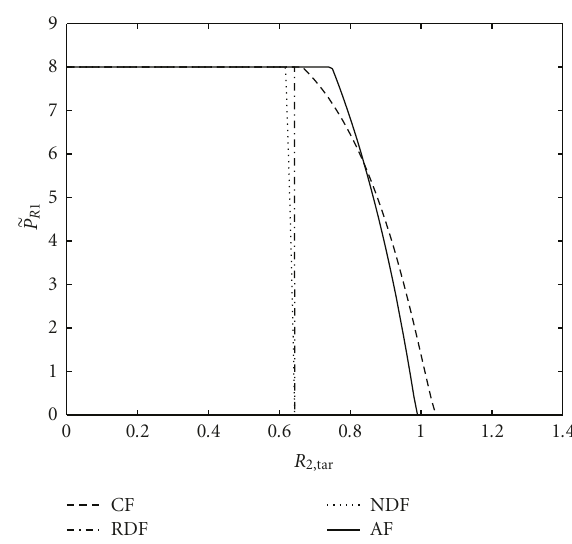
Figure 4: Powers allocated by the jointly optimal algorithm in Scenario 1.